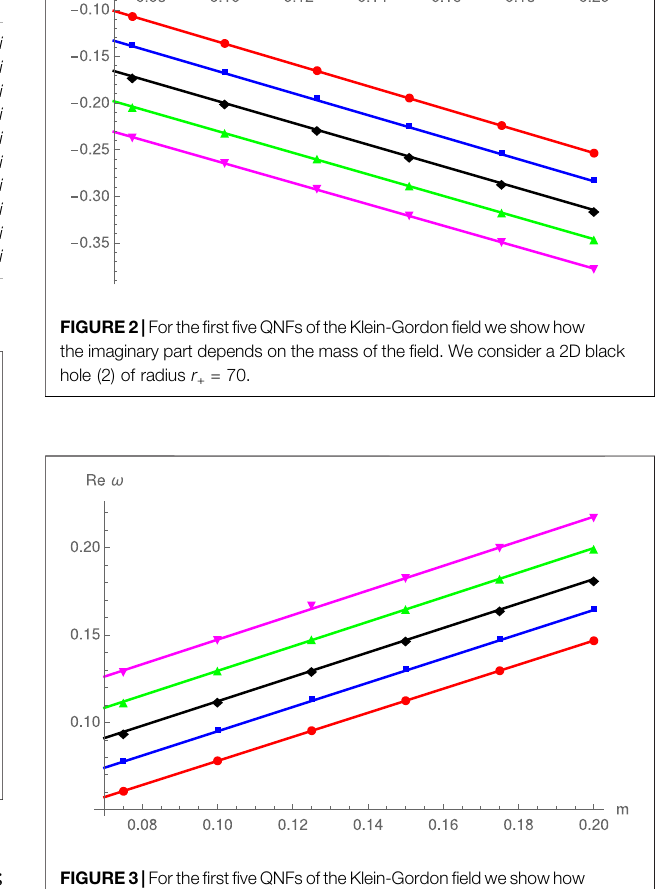
Mode number Linear fi t for Im ( ω )